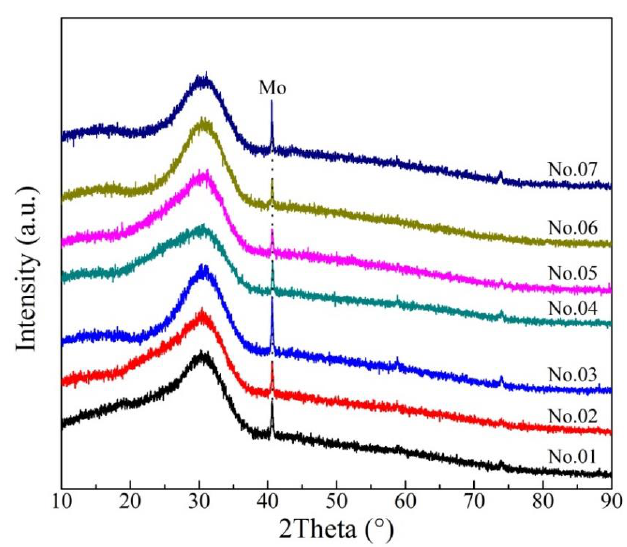
Figure 6. Patterns of the rapidly quenched slag samples.